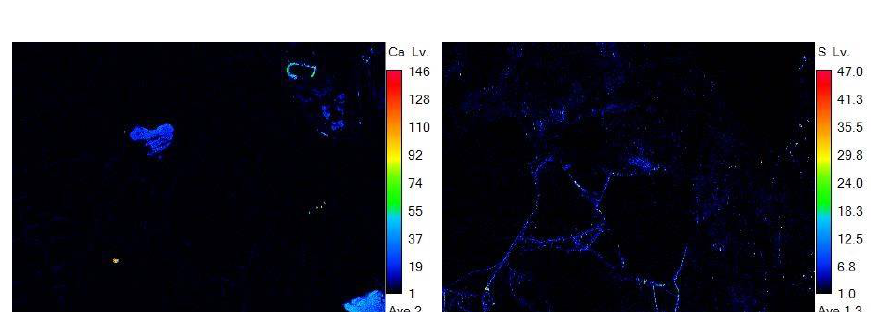
Figure 8. Distribution of the main elements in titanomagnetite.